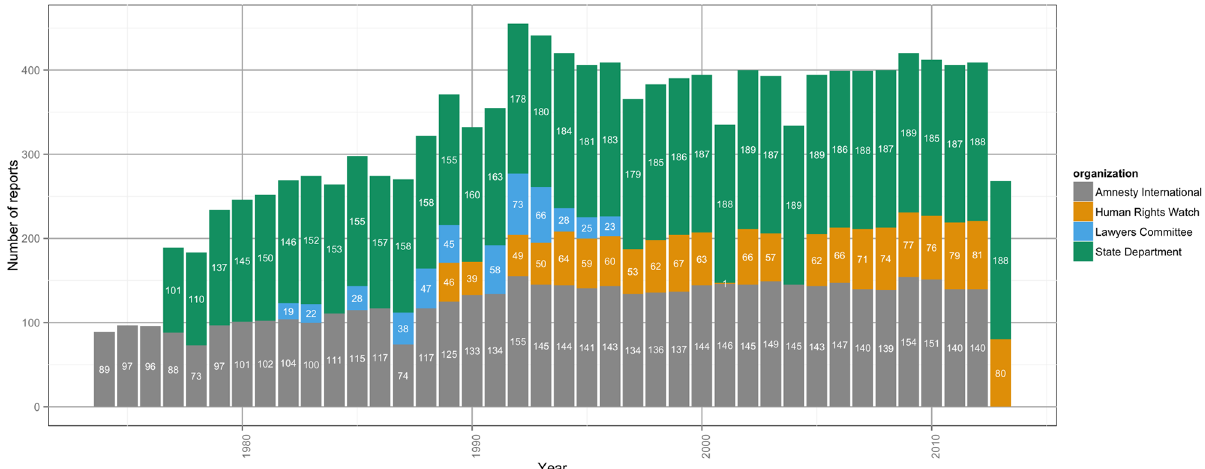
Fig 1. The number of human rights documents by year from the four publication sources that we have collected. The figure shows the year-by-year distribution of reports by Amnesty International (grey), Human Rights Watch (orange), the Lawyers Committee for Human Rights (blue), and the United States Department of State (green). The increasing number of reports each year coincides to both expanding coverage in the early years of the series and the increasing number of countries that enter the international state system. Some of the older documents are not easily found. We will continue to search for missing documents and eventually plan to expand this corpus to a large number of human rights